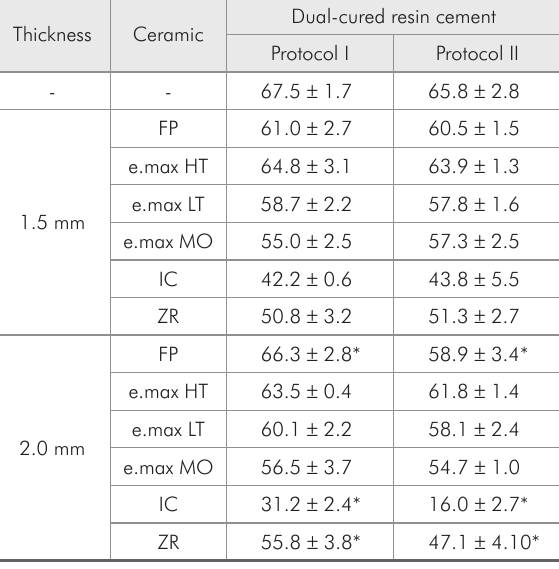
Table 2 - Means and standard deviations for the degree of conversion (in percentage) obtained for the dual-cured resin cement when using two different protocols to obtain the spectra of uncured materials.